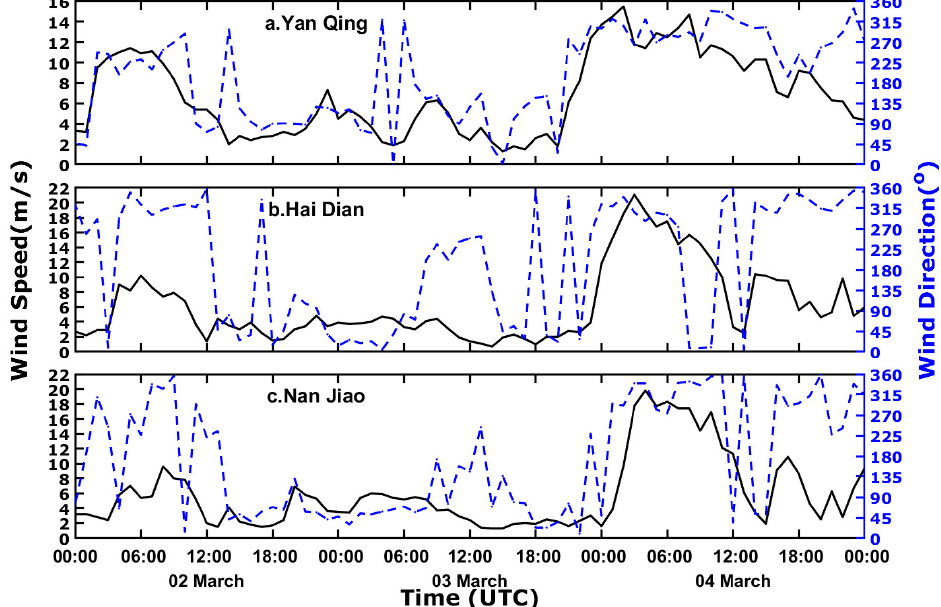
Figure 8. Wind speed and direction on the surface of each region (( a ). Yanqing, ( b ). Haidian, and ( c ) Nanjiao). ( c ). Nanjiao).